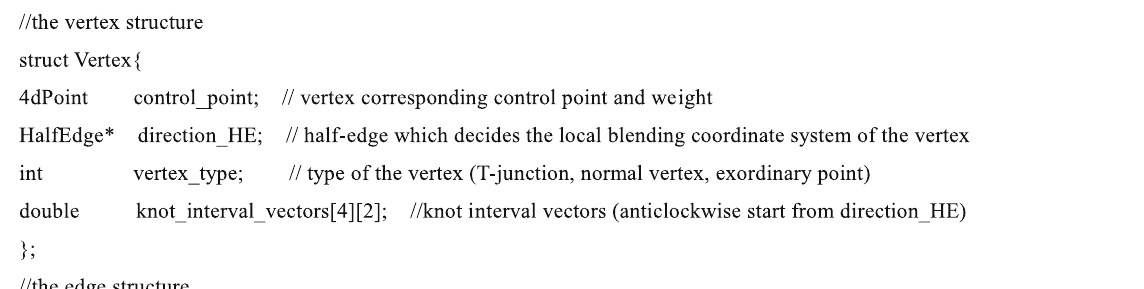
Table 1 The data structure for the unstructured